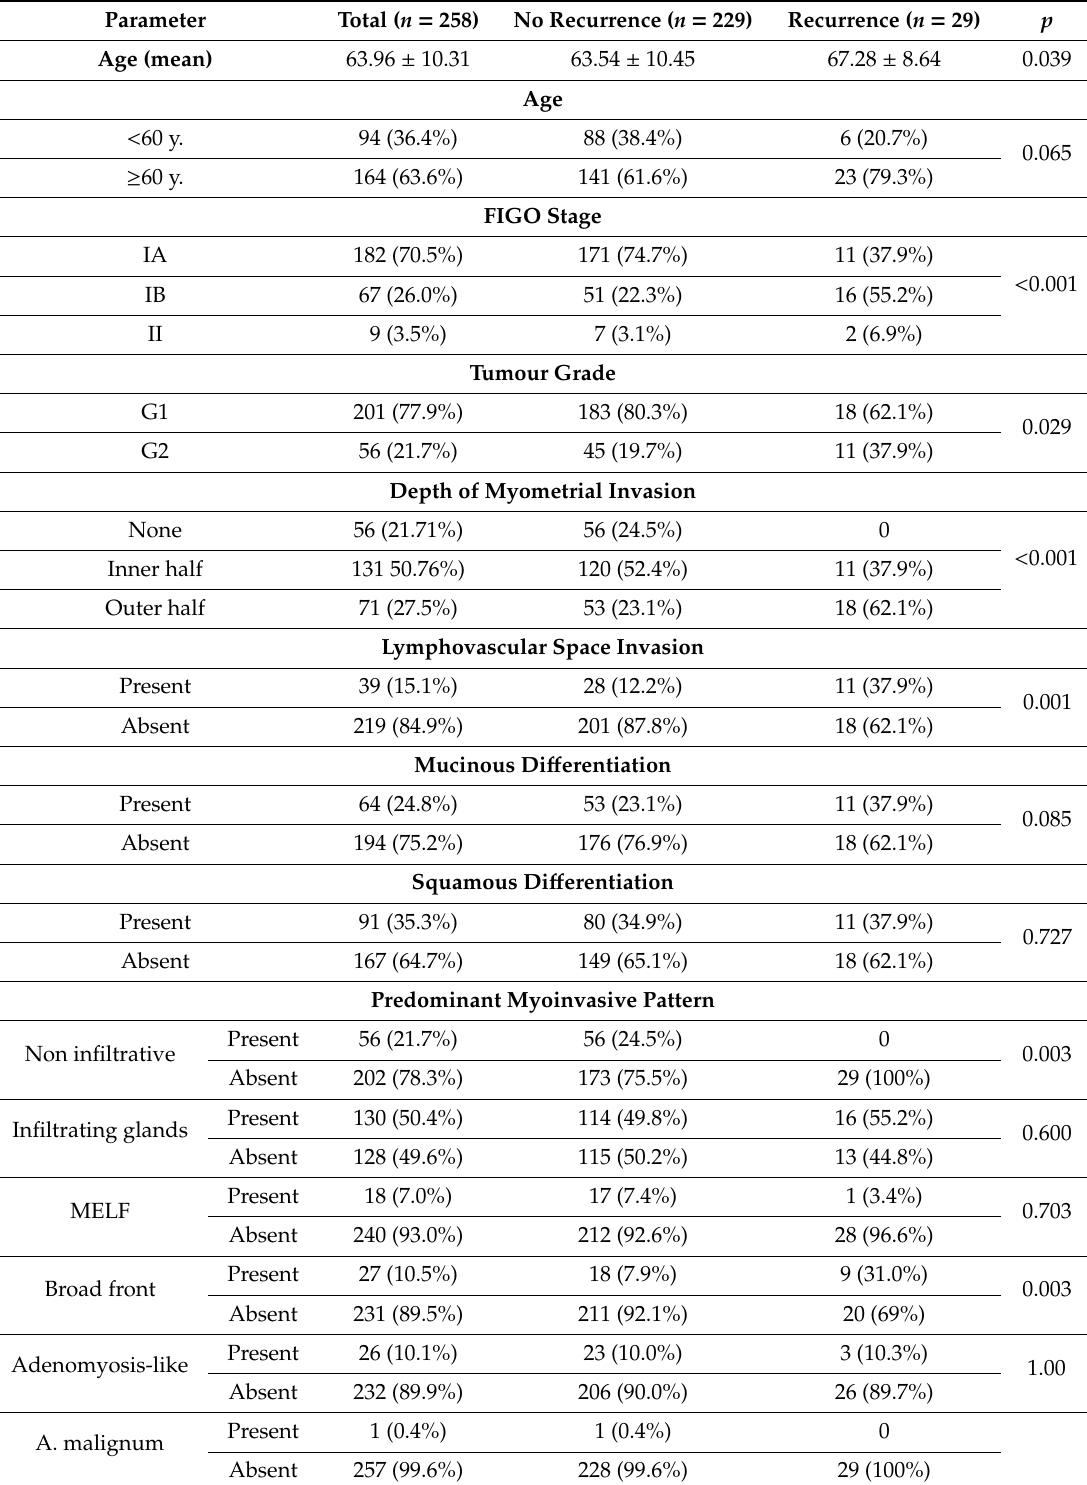
Table 1. Clinicopathological characteristics of the study